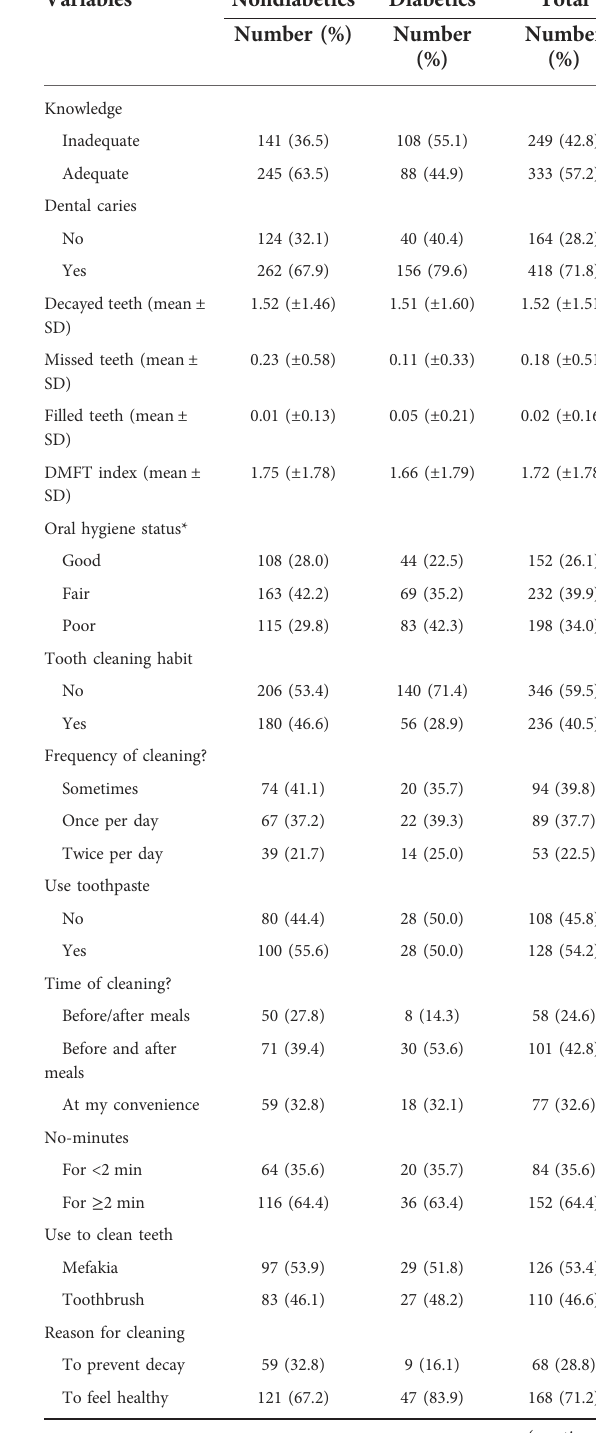
TABLE 3 Knowledge and practice on oral health of study participants attending the outpatient department in BPH, northwest Ethiopia,